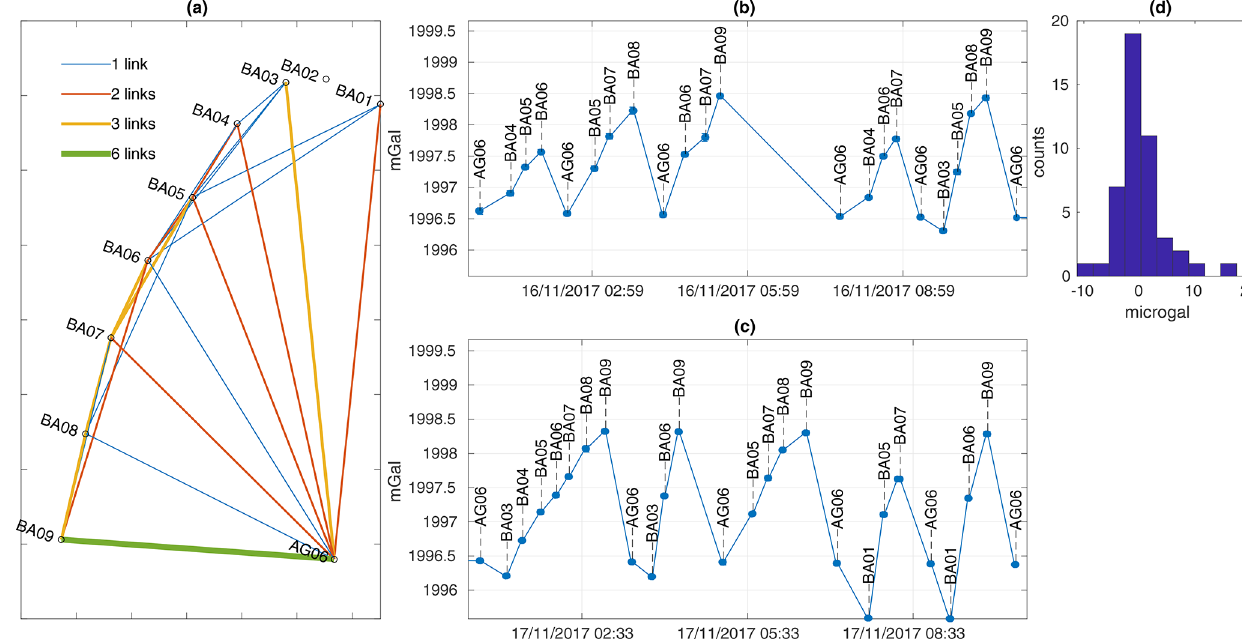
Figure A3. (a) Map view of the relative gravity network with the link between each site for the 2017 survey. (b, c) Gravity readings on the CG-5 at each site as a function of time. (d) Histogram of the residuals after the drift